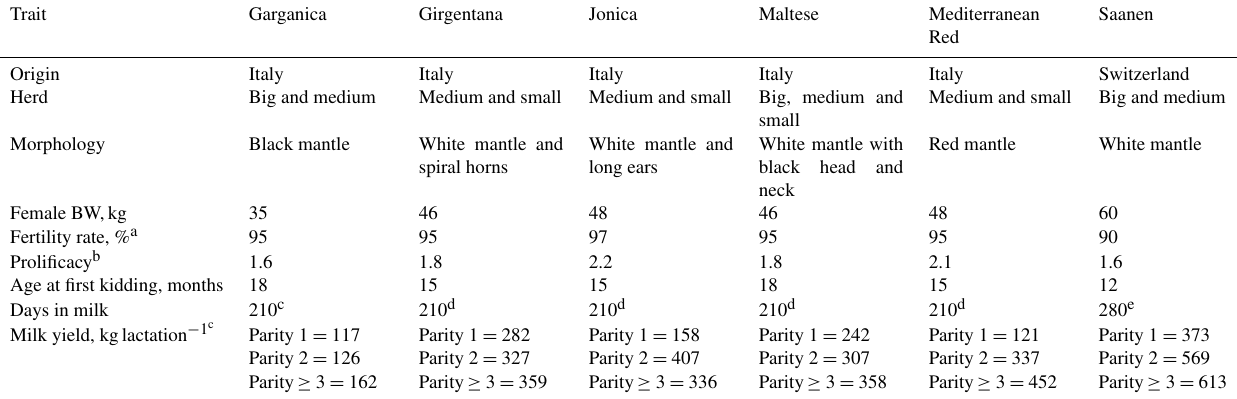
BW:bodyweight. a Fertilityrate:numberofkiddingdoes/numberofinseminateddoes. b Prolificacy:numberkids/kidding. c InformationretrievedfromNoèetal.(2005). d InformationretrievedfromDiTranaet al.(2015). e